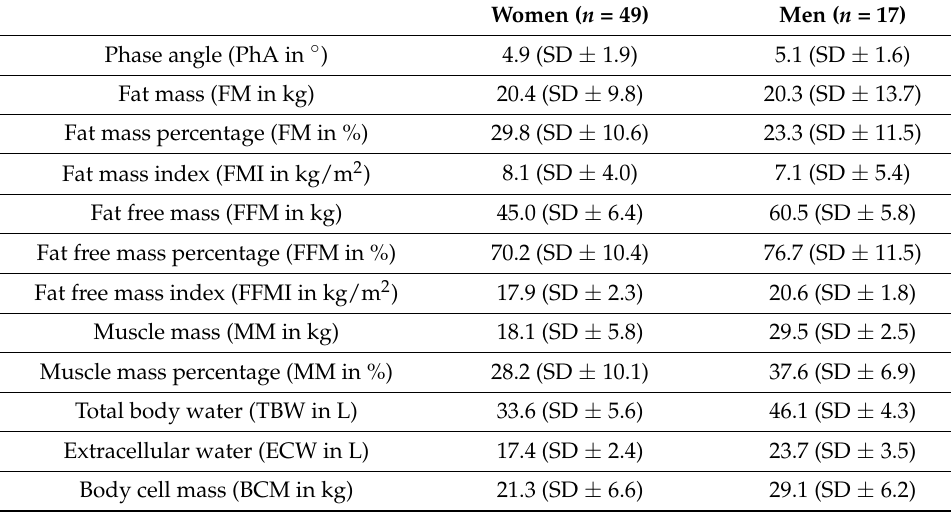
Table 3. Body composition of the BaSAlt